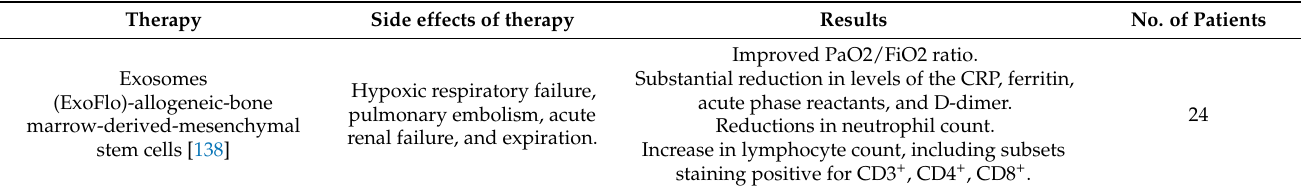
Table 3. Results of completed clinical trials studying MSC therapy to treat COVID-19 conditions. Therapy Side effects of therapy Results